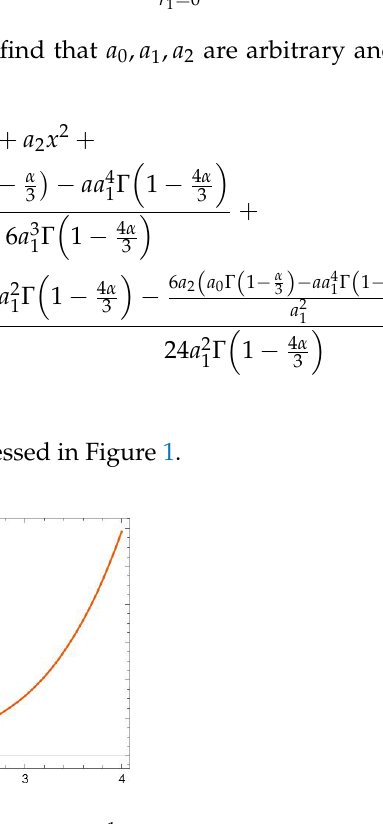
Figure 1. We let a 0 = a 1 = a 2 = a = 1, α = 1